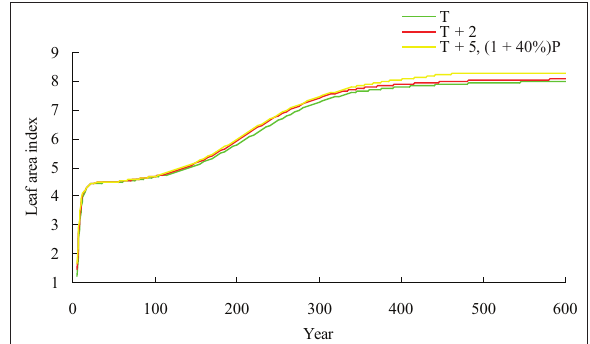
Figure 3. Temporal changes in the annual